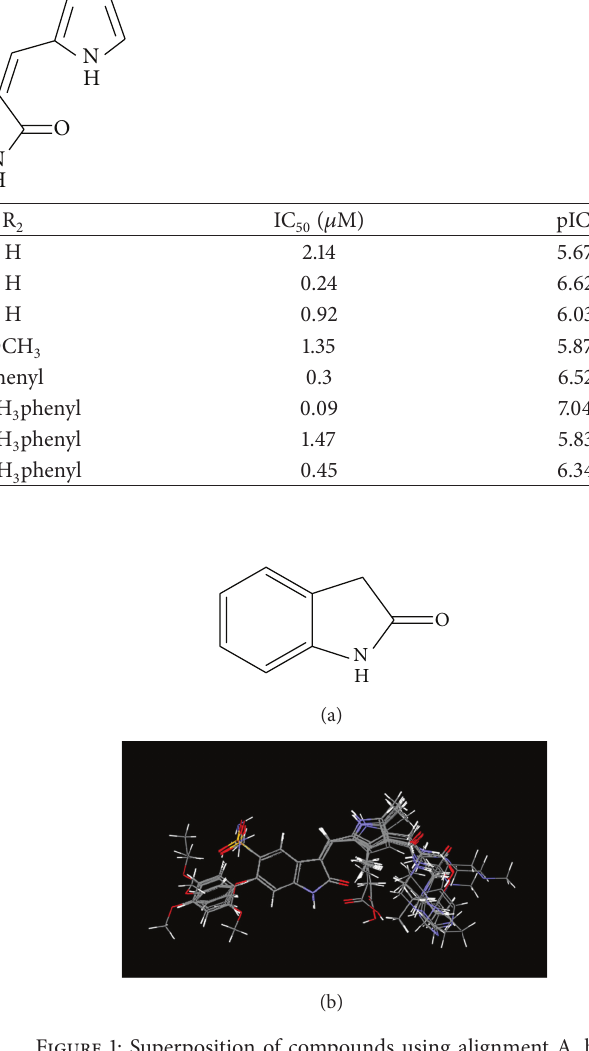
Figure 1: Superposition of compounds using alignment A, based on common structure. (a) Common fragment for superposition; (b) superposition of compounds in training and test